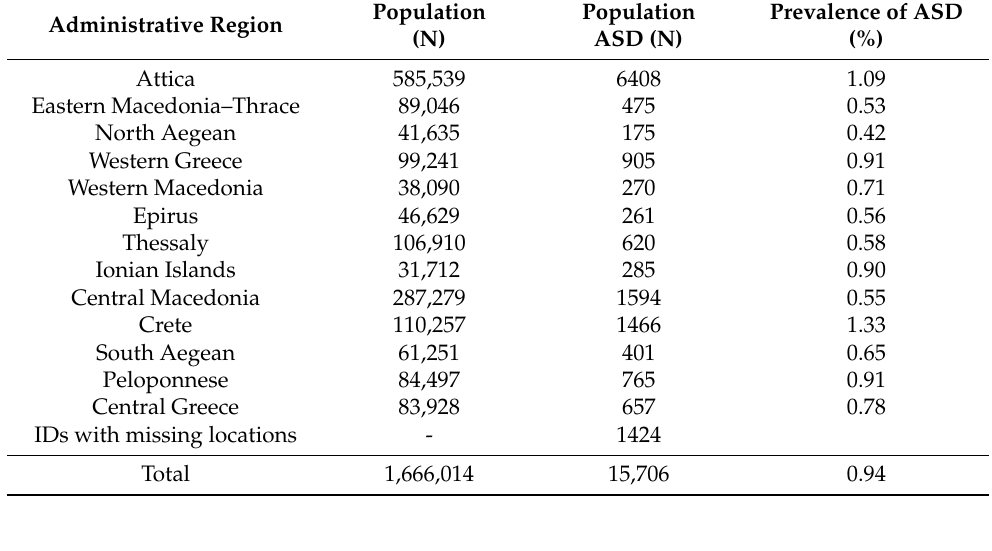
Table 2. The prevalence of ASD in Greece in 2021 for children aged 2–17 years.